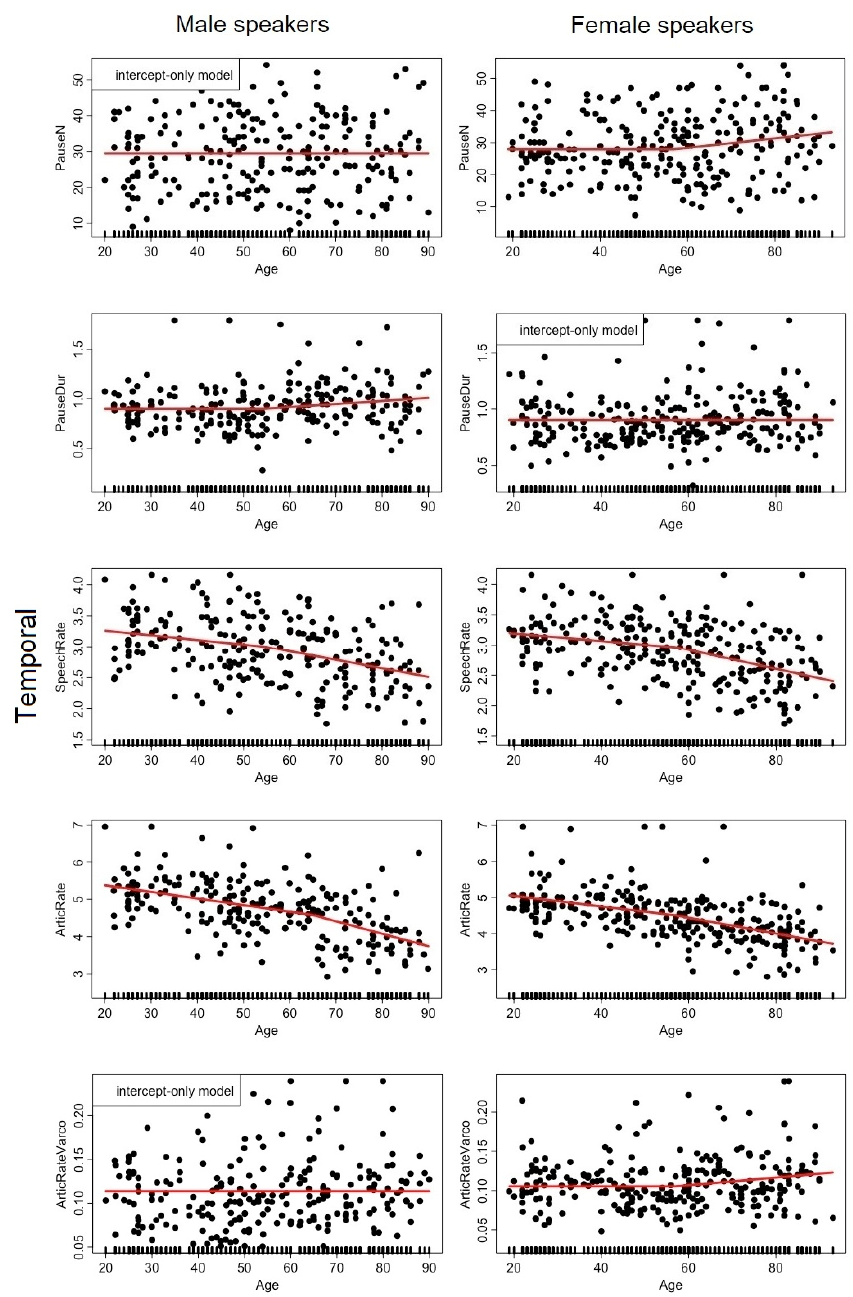
Figure A4. Dot plot of each descriptor ( y -axis) capturing aspects of the TEMPORAL dimension as a function of age ( x -axis) for the male ( left ) and female ( right ) speakers. The hinge function of the MARS model is represented by the red curve. Each dot corresponds to a speaker.